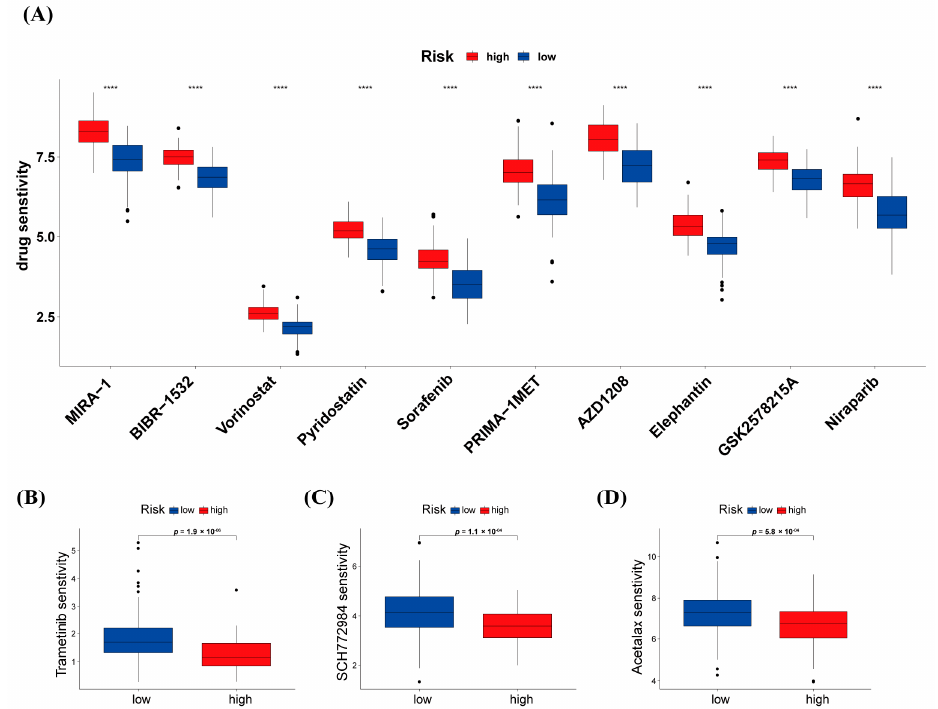
Figure 8. Prediction of drug sensitivity based on warlncRNAs signatures. ( A ) The top ten drugs with resistance in high-risk populations in the training cohort. ( B-D ) The potential drugs could con- tribute to the therapy of PAAD patients in the low-risk group.